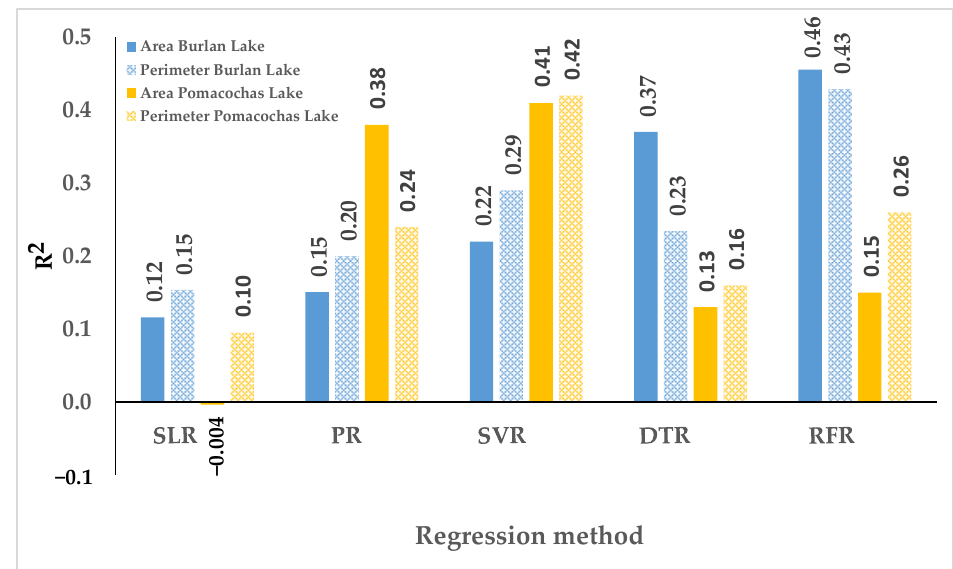
Figure 9. Regression models with higher R 2 for the area and perimeter data of Pomacochas Lake. For Burlan Lake, with the AVV and DVV combinations classified by CART, RFR obtained the best R 2 for the area (0.46) and perimeter (0.43), respectively. In turn, for Pomacochas Lake, the combination DVH classified by SVM and AVH classified by RF obtained the best R 2 for the area (0.41) and perimeter (0.42), respectively, according to SVR. Next, Figure 10 compares the R 2 of each regression method. It can be seen that for Burlan Lake, RFR showed higher R 2 in the area and perimeter data, thus showing an average adaptation of the model to the data, while for Pomacochas Lake the model that best fits the area and perimeter was the regression model by support vectors.